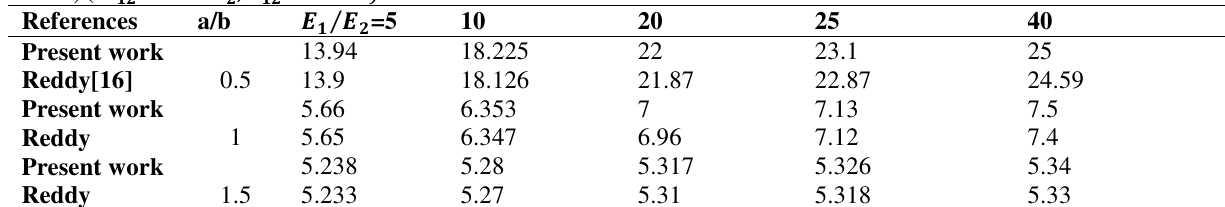
Non-dimensional buckling load